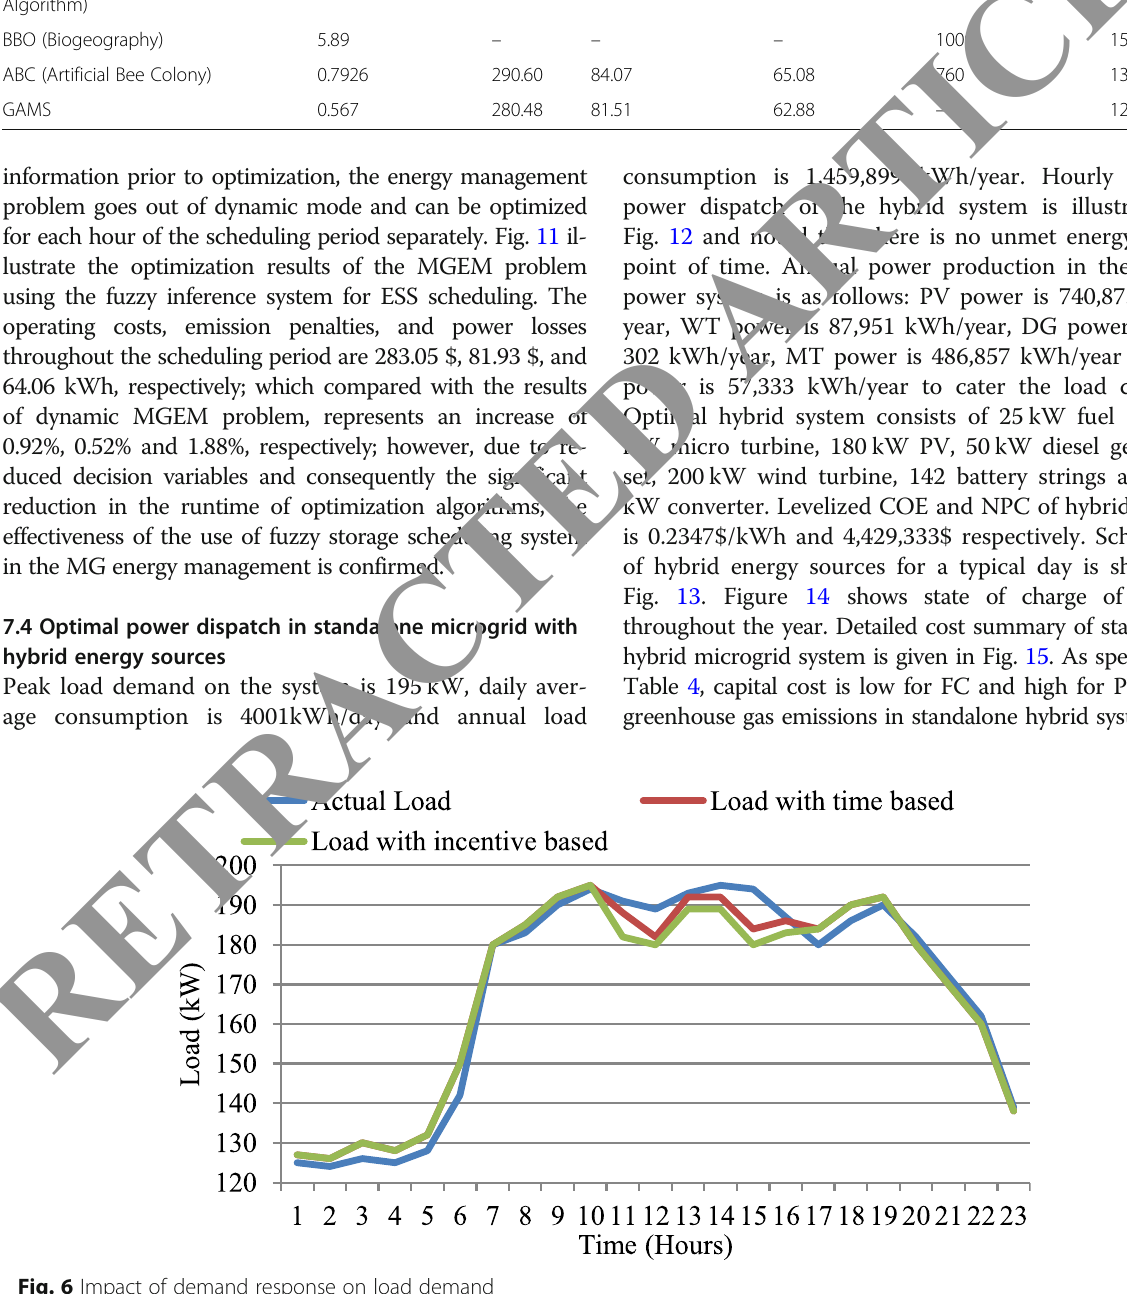
Fig. 6 Impact of demand response on load